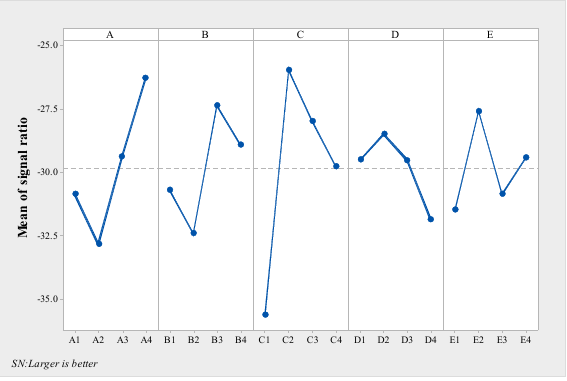
Figure 35. The effect of each design factor on Fr. Figure 35. The e ff ect of each design factor on Fr